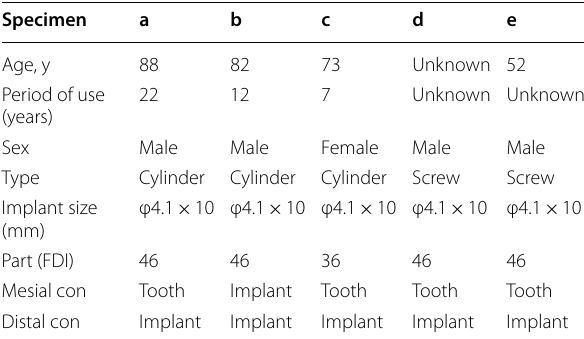
Table 1 Details of the cadavers’ age, period of implant use, sex, and dental implants’